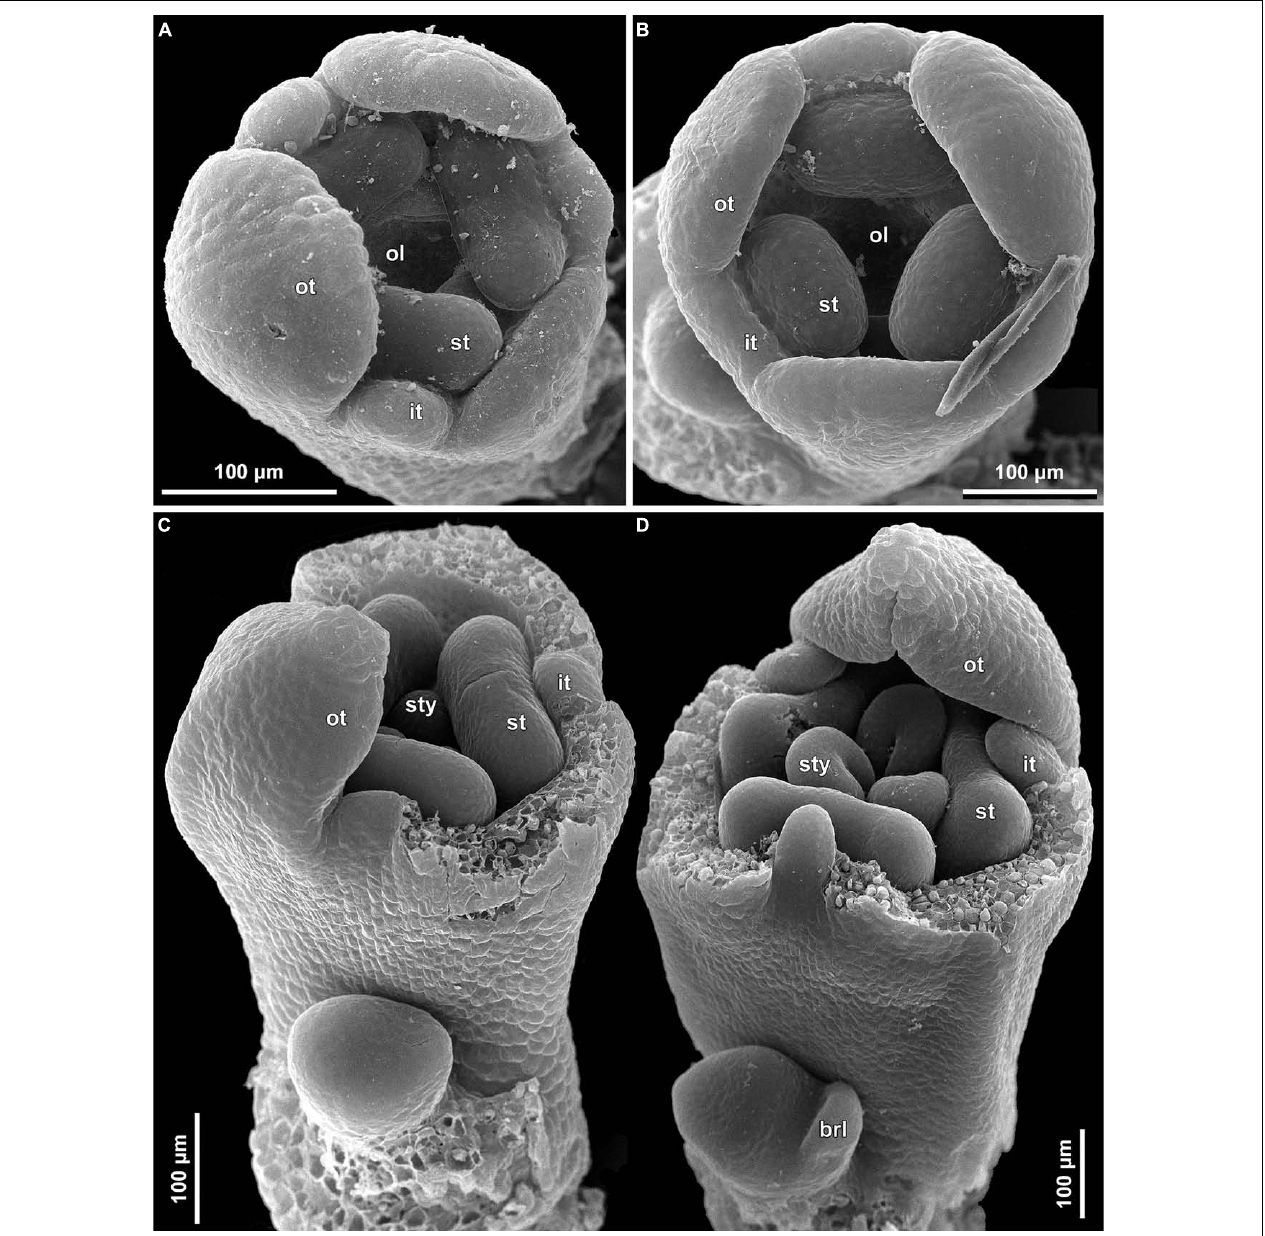
FIGURE 12 | Floral development of Burmannia (SEM). (A) Burmannia chinensis . Flower after initiation of ovary locule; one outer tepal lobe is significantly larger than the others. (B–D) Burmannia coelestis ( Truong Ba Vuong, Dang Van Son BV1000 ). (B) Flower at initiation of ovary locule. (C,D) Flowers at initiation (C) and development (D) of styles; two outer tepal lobes removed. brl, bracteole; it, inner tepal; ol, ovary locule; ot, outer tepal; st, stamen; sty,